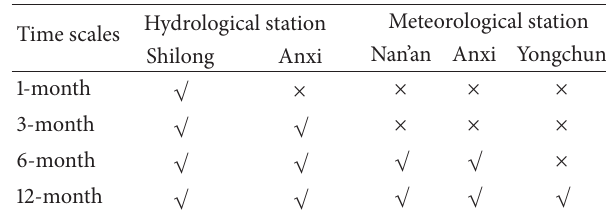
Table 1: Fitting theoretical probability distributions of Log-Normal functions for streamflow and precipitation at 1-, 3-, 6-, 12-month time scales with K-S